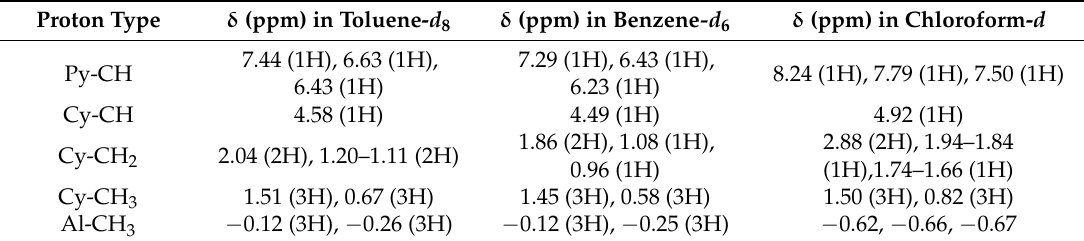
Table 3. The 1 H NMR chemical shifts for C1 recorded in different deuterated solvents.